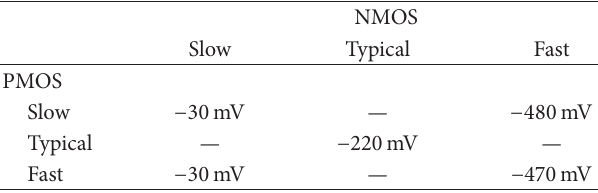
Table 5: Corner analysis of 𝑉 during first recall. d1 NMOS Slow Typical Fast